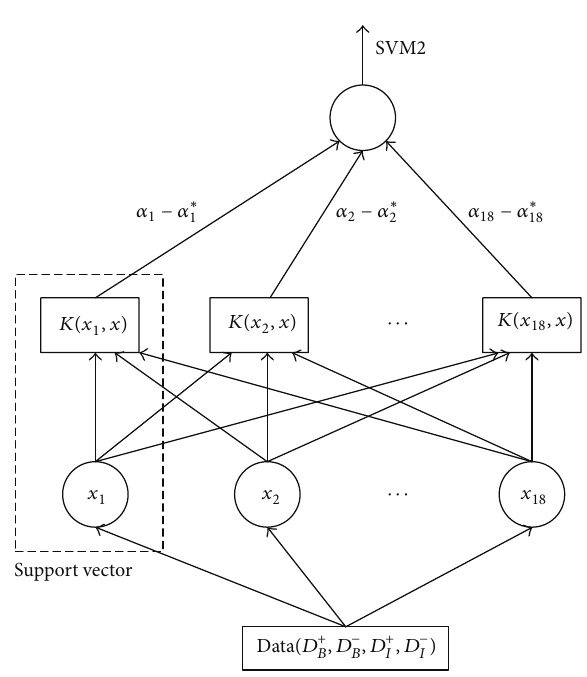
Figure 8: The structure of